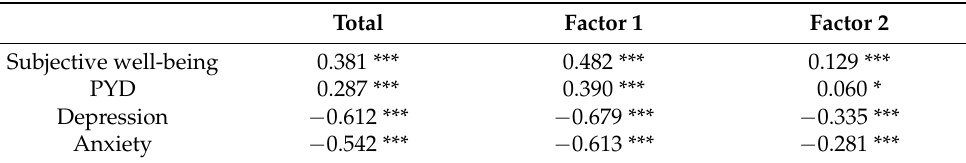
Table 3. The correlation coefficients of the total scores and factor scores of the Chinese version of the CAMM and six criteria ( n = 1283).